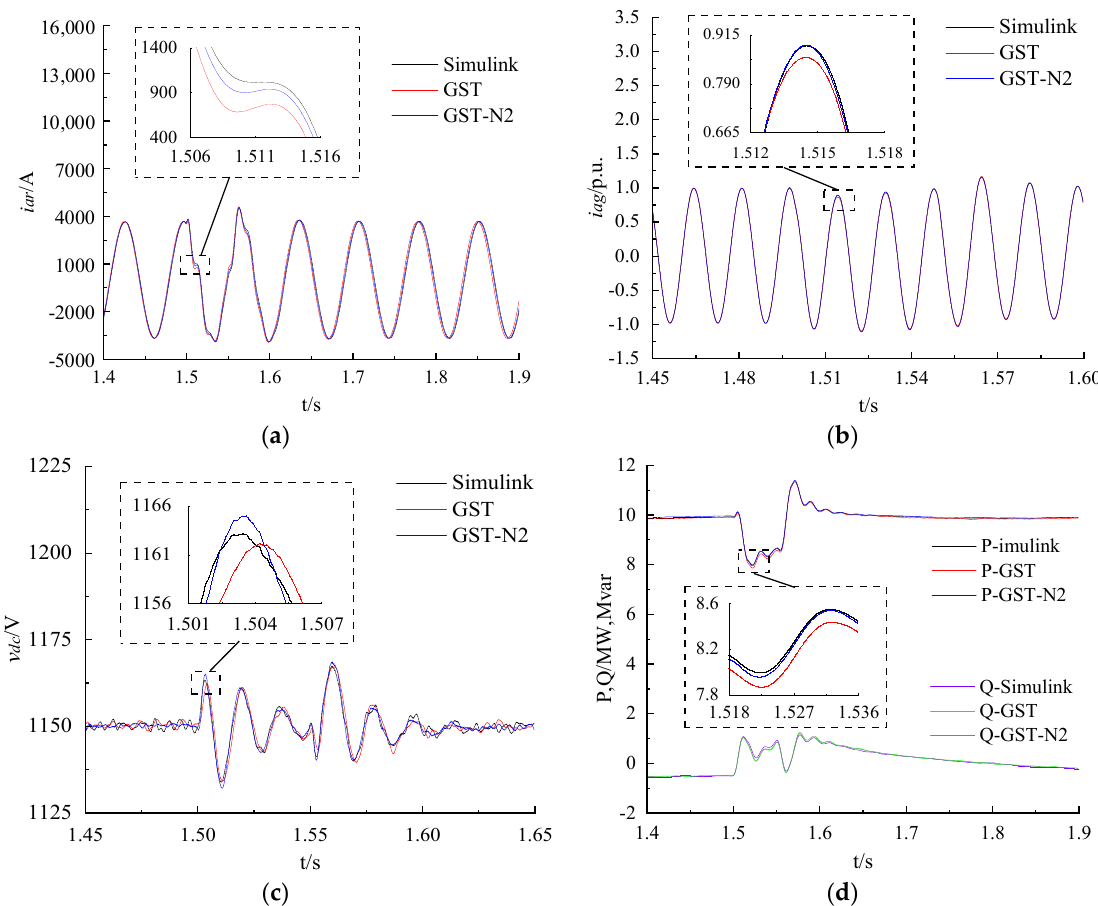
Figure 16. Comparison of simulation waveforms in scenario A: ( a ) Rotor-side current waveform; ( b ) Connection point current waveform; ( c ) DC capacitance-voltage waveform; ( d ) P, Q waveform. Scenario B: A phase-to-ground short-circuit in phase A occurs at the wind turbine connection point at the moment of 2 s, and the fault duration is 0.01 s. The simulation results obtained are shown in Figure